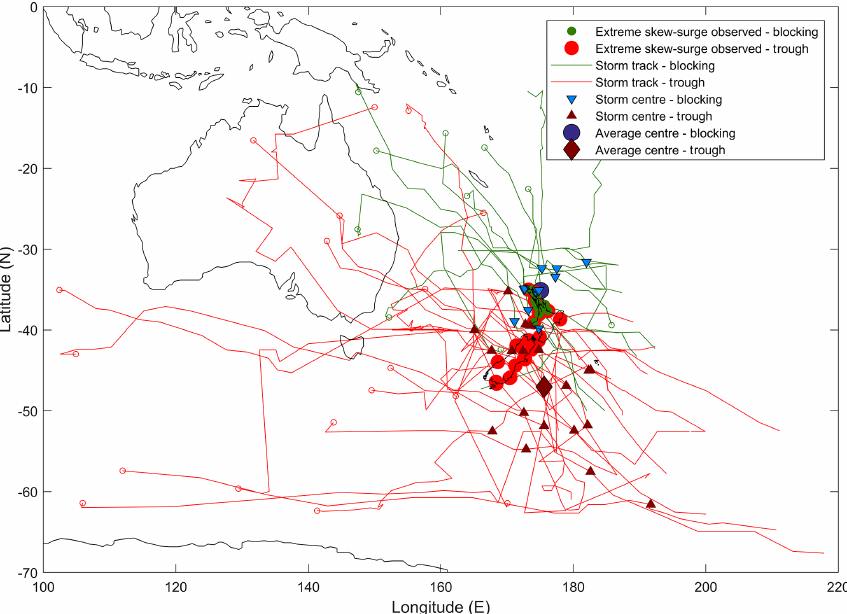
Figure 6. Storm tracks and weather types contributing to all the storm-tide or skew-surge events that impacted at least three tide gauge sites. Storm tracks and the location of the storm centre at storm-tide event peak are marked for both blocking (green and blue) and trough (red and brown) Kidson (2000) weather types. Open circles denote storm track origin.